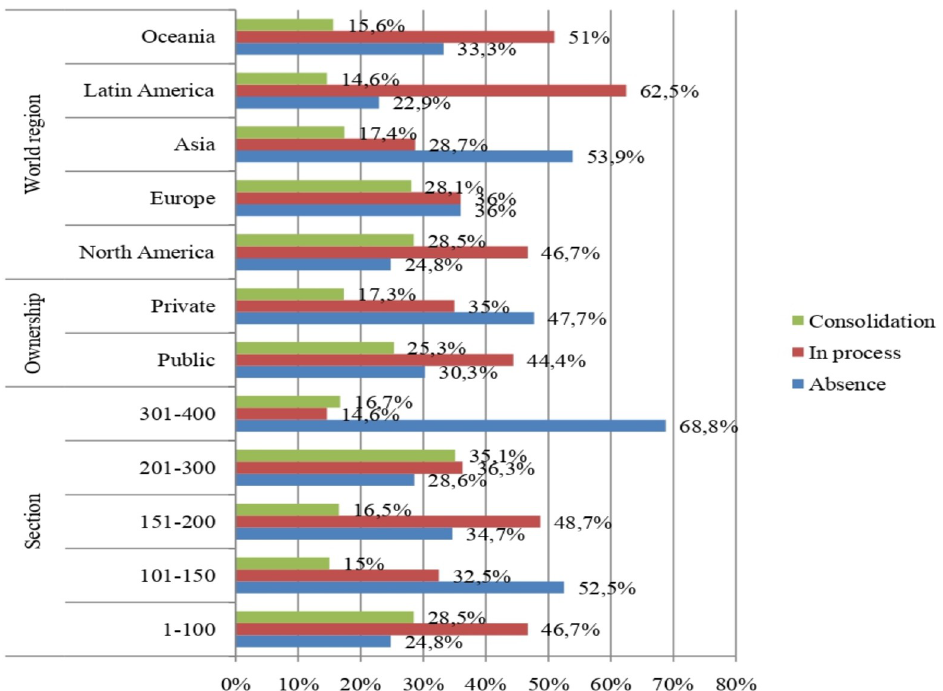
Fig 1. Relative frequencies of indicators at each institutionalisation level in relation to the section, ownership and world region.